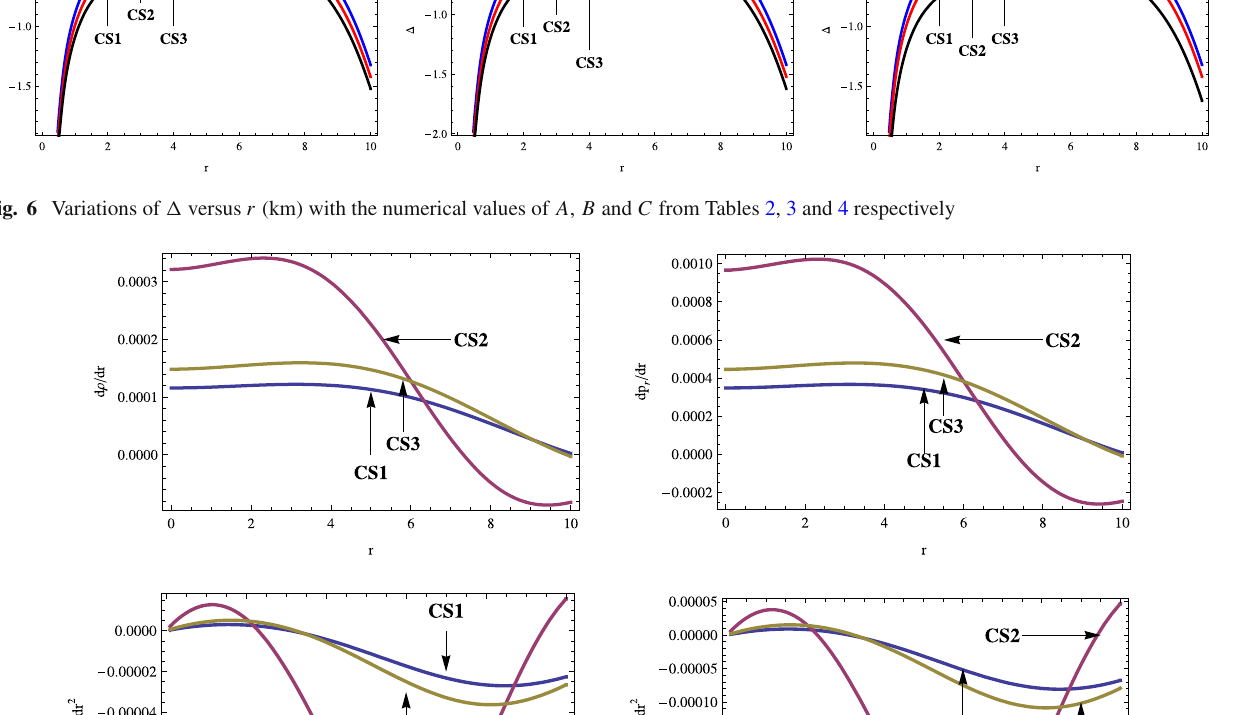
, dp r , d 2 ρ and d 2 p r with respect to r (km) with the numerical values of A , B and C from Table 2 dr dr dr 2 dr 2